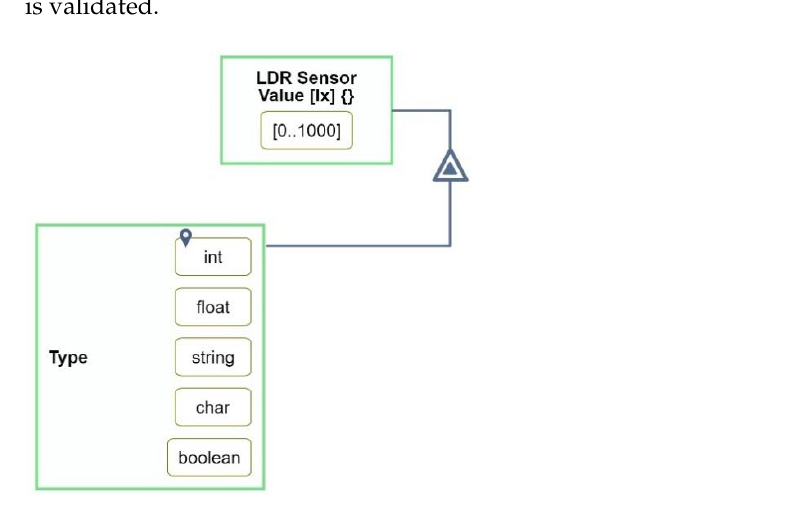
Figure 12. An example of a computational object with the meta-attribute Type. Type cannot be deleted, but it can be hidden when its exhibitor (e.g., LDR Sensor Value in Figure 12) is folded. Type can be hidden or shown at will be toggling it with a click of a button, which shows up only when a computational object is